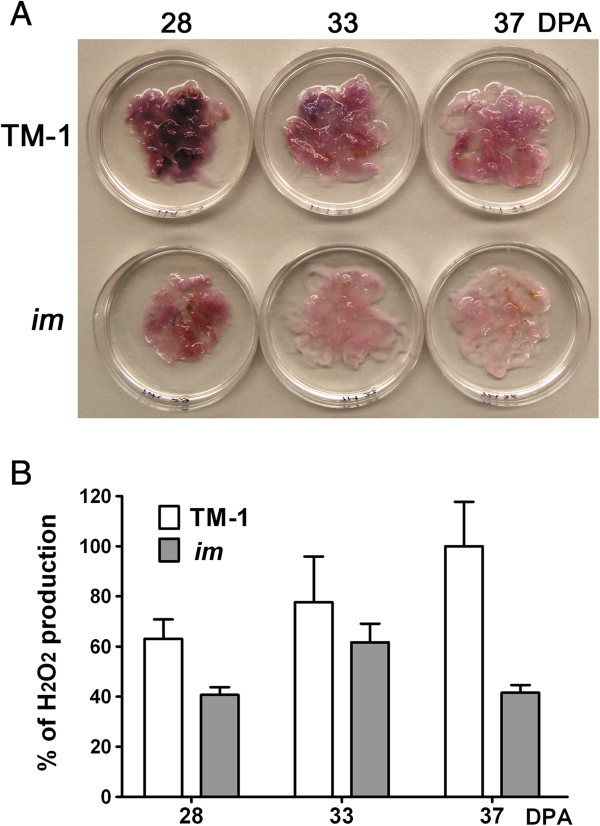
Comparison of ROS levels of developing fibers from TM-1 and im mutant. A. Superoxide radicals were detected by NBT staining from freshly harvested developing fibers at 28, 33, and 37 DPA from TM-1 and im mutant. B. Relative productions of H2O2 in developing cotton fibers were quantitatively measured from freshly harvested developing fibers at 28, 33, and 37 DPA from TM-1 and im mutant. Three biological replications and three technical readings at each time point were performed. The error bars represent SD.